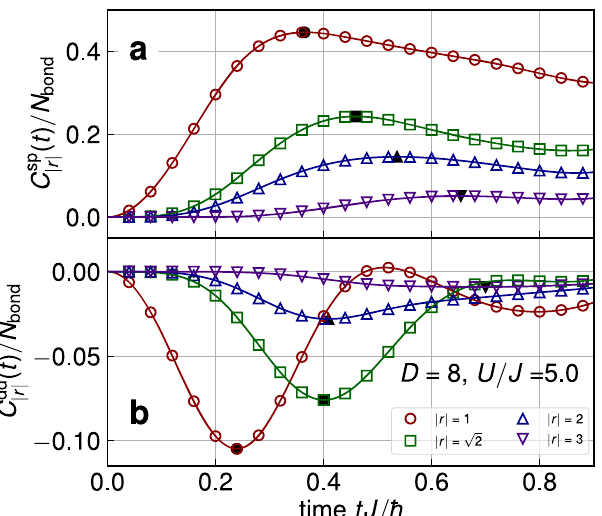
Fig. 4 Single particle and density – density correlation functions used to extract the propagation velocities. a Single-particle [ C sp r ð t Þ ] and ( b ) density – density [ C dd r ð t Þ ] correlation functions per bond at the interaction strength U / J = 5 for the bond dimension D = 8. The unit of time is taken as the inverse of the strength of the hopping J . The normalization factor at a distance r = ( x , y ) is given as N bond = 2 for x ≠ y ( ∣ r ∣ = 1, 2, and ffiffiffi p 3), while it is N bond = 4 for x = y ( j r j ¼ 2 ). The black symbol corresponds to the fi rst peak in the correlation function obtained by cubic spline interpolation of data points. The propagation velocities along the horizontal or vertical axis are extracted by the data at ∣ r ∣ = 1, 2, and 3. The velocity estimated from the density – density correlation functions is slower than that from the single-particle correlation